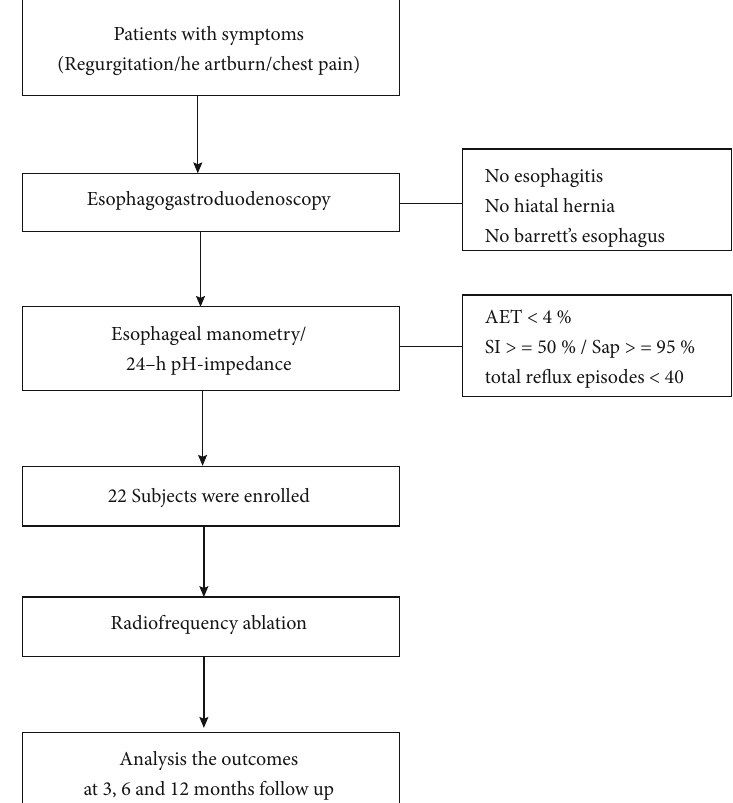
Figure 1: Study fl ow diagram.